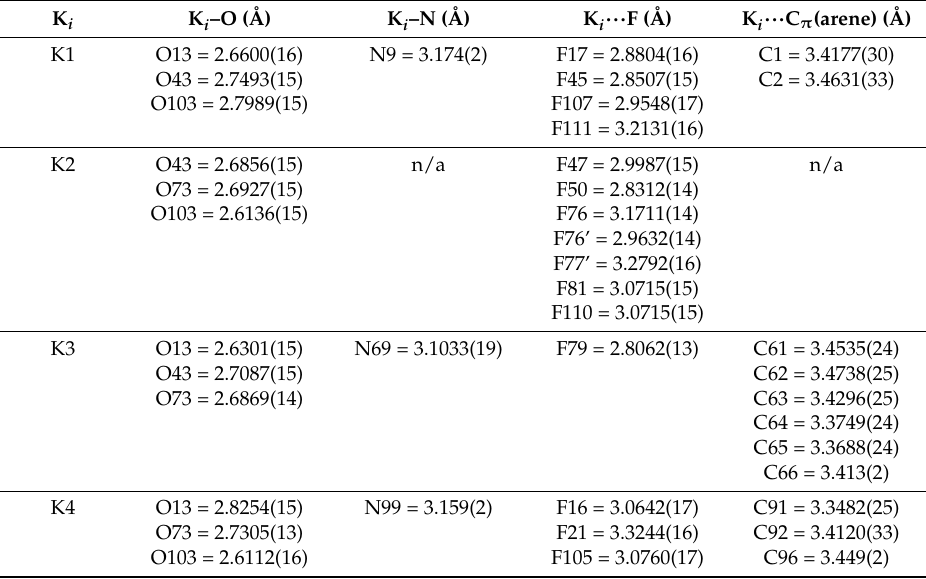
Table 1. Key metric parameters in the potassium–arene complex [{RO 1 }K] 4 ([ 1 ] 4